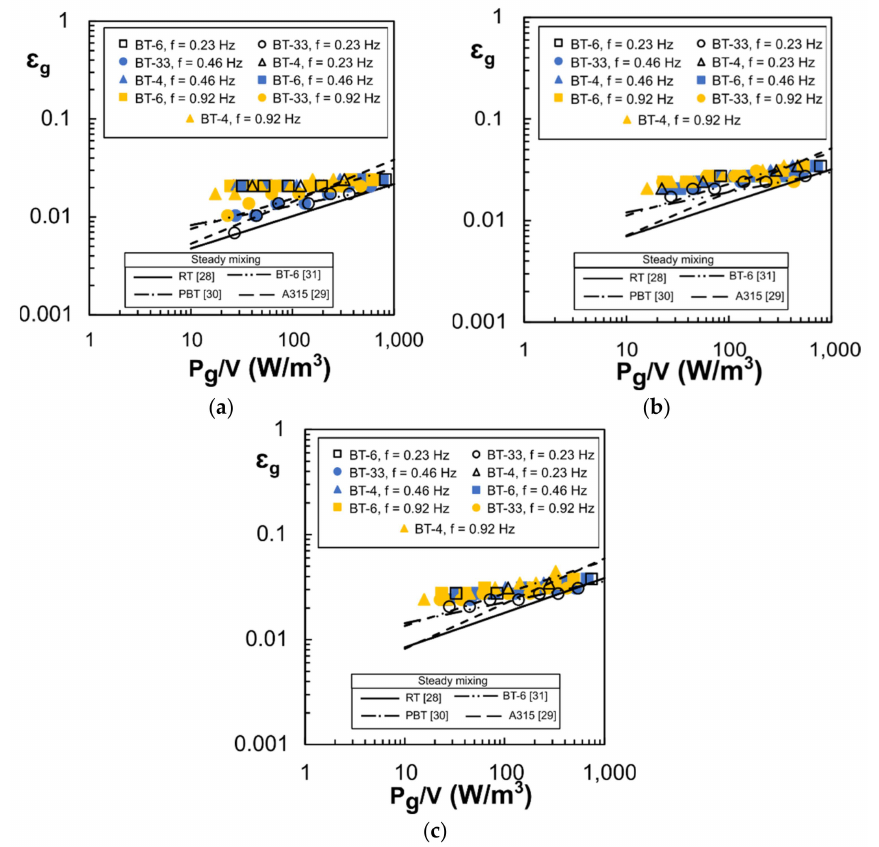
Figure 5. Relation between gas hold-up and P g /V for BT-33, BT-4, and BT-6 impellers: ( a ) v g = 0.0021 m/s, Q g = 0.5 m 3 /h; ( b ) v g = 0.0038 m/s, Q g = 0.9 m 3 /h; ( c ) v g = 0.005 m/s, Q g = 1.2 m 3